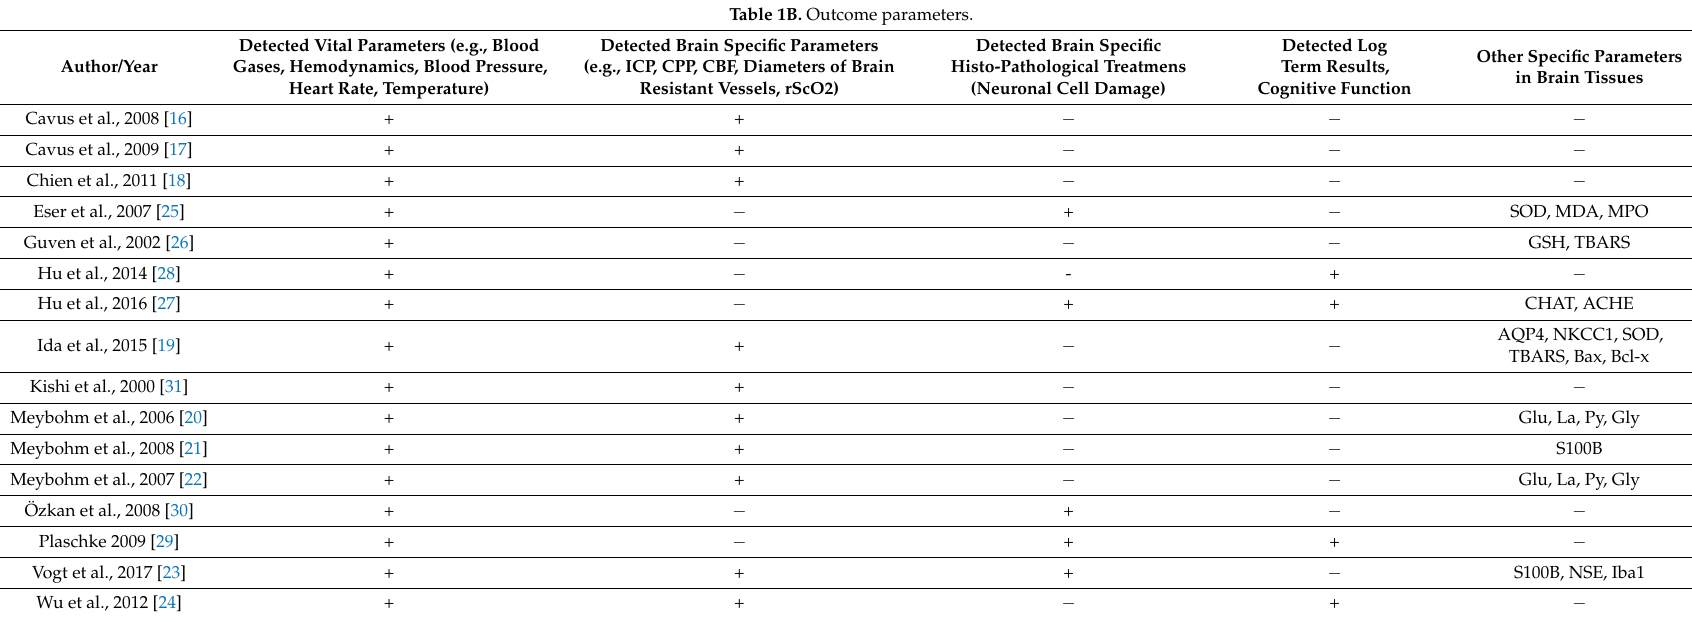
Table 1B. Outcome